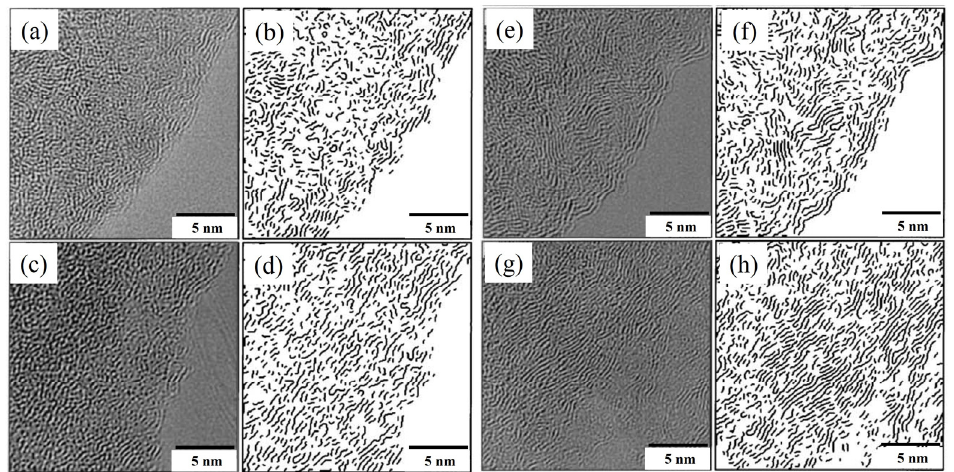
Figure 16. HRTEM image and stripe group: ( a , b ) original coal sample; ( c , d ) coal pyrolysis sample at 427 °C; ( e , f ) coal pyrolysis sample at 800 °C; ( g , h ) coal pyrolysis sample at 1200 °C [94].